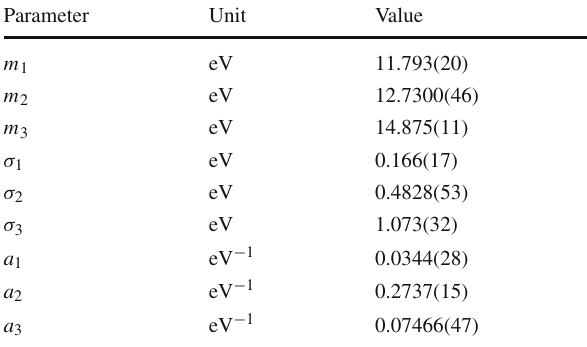
Table4 Best-fitparametervaluesfortheenergy-lossfunctioninmolec- ular deuterium as described in Eq. (2). Parameter correlations are pro- vided as a covariance matrix in Table